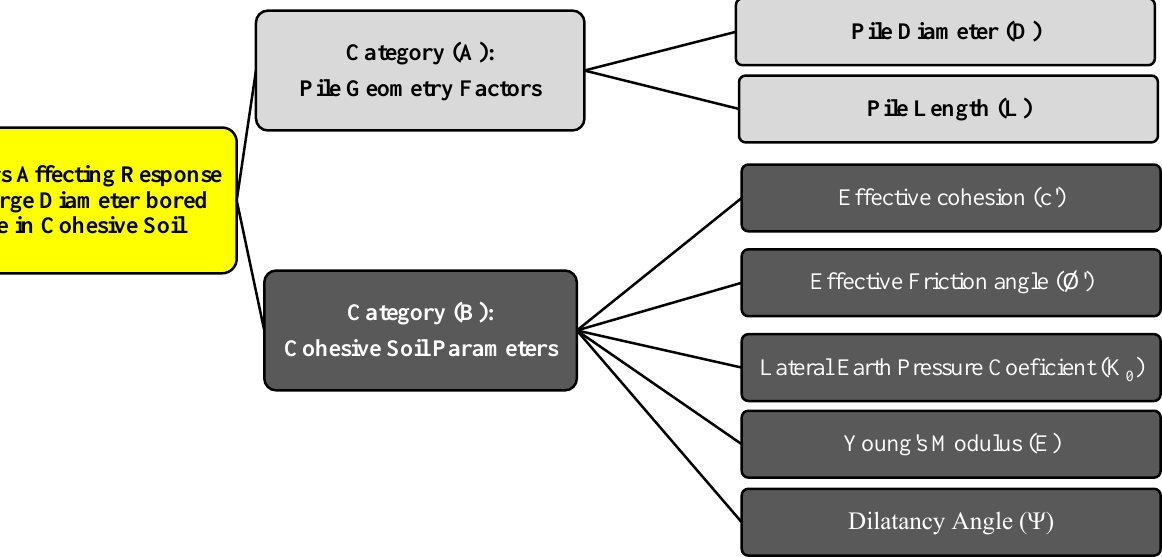
Figure 3. Factors affecting the behavior of large diameter bored pile in cohesive soil.